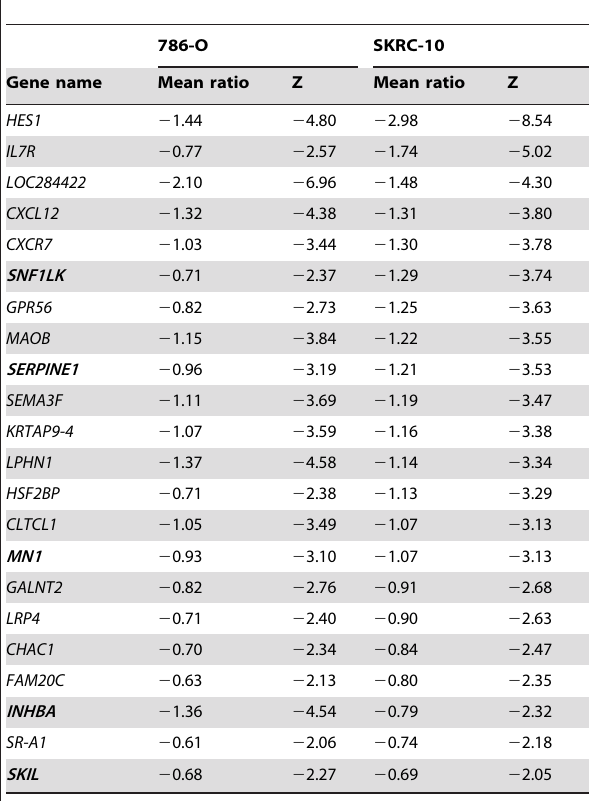
Genes in bold represents previously described TGF- b signaling target genes. Data represents mean log 2 ratios (DAPT/DMSO) and Z-scores of three separate experiments. The genes are sorted according to the Z-scores of SKRC-10.